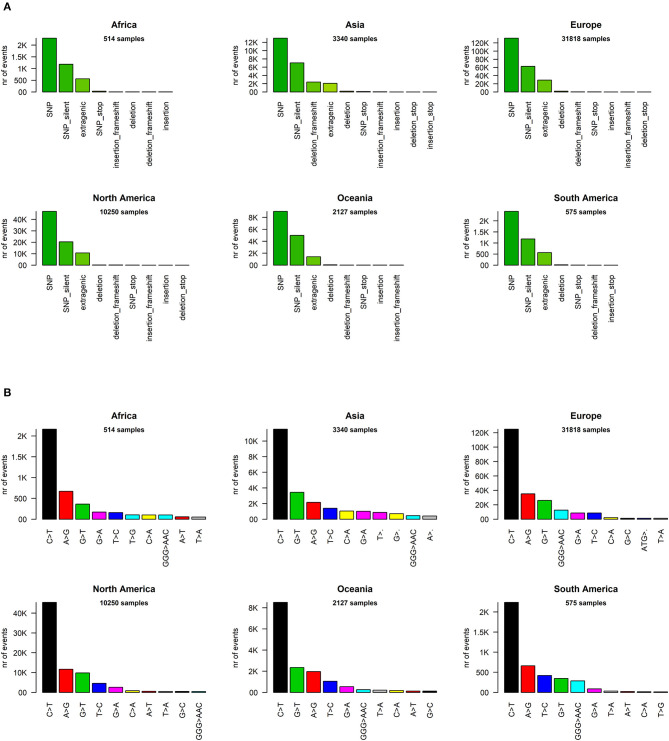
(A) Distribution of SARS-CoV-2 mutation classes in continents. “SNP,” “deletion,” and “insertion” terms without further specifications are intended as frameshift-preserving aa-changing events. (B) Continent-stratified distribution of SARS-CoV-2 mutation types. Colors are assigned randomly but preserved across panels to facilitate tracking of identical types across continents. Listed nucleotide changes represent those found in the positive-sense viral RNA. We indicate the thymine T letter for consistency with the NCBI reference sequence NC_045512.2, but the actual viral sequence will be factually represented by a U (uracil) as the RNA counterpart for thymine. Dots (‘·’) on the x-axis mutation type names indicate nucleotide deletion.